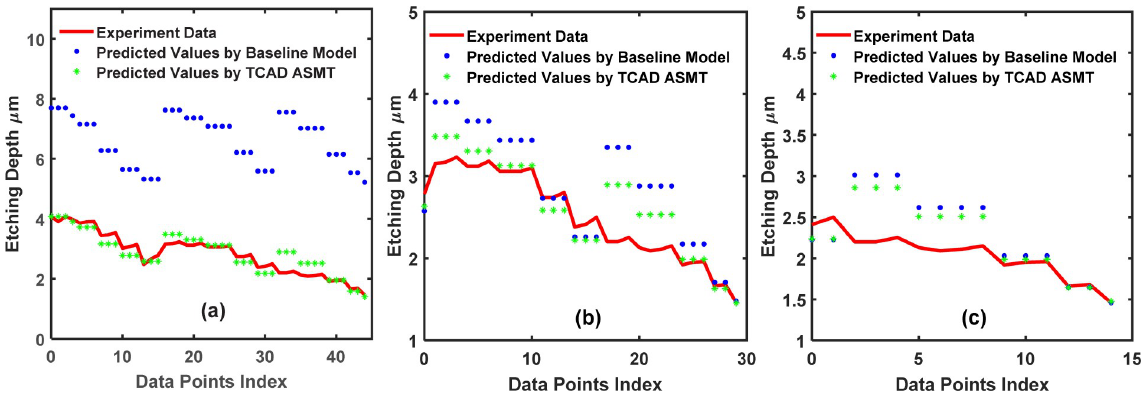
Fig 12. Comparison between the test set prediction using the baseline conventional NN and the TCAD-labeled ASMT algorithm for the 2-input dataset. (a), (b) and (c) show the predicted values for the partition values,15, 30, and 45, respectively.